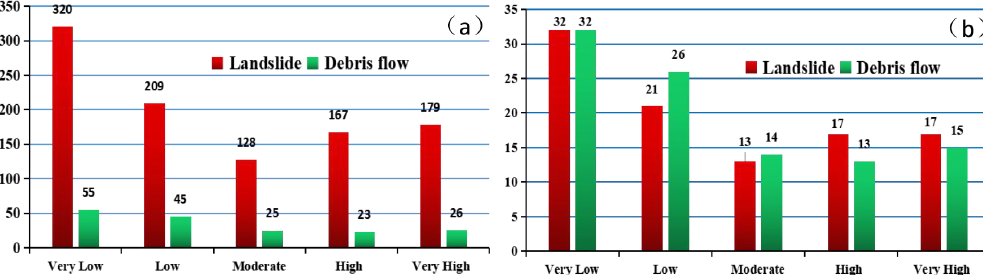
Figure 9. Numbers and percentage of units in different susceptibility classes for landslide and debris flow: (a) number of units in different susceptibility classes for landslide and debris flow and (b) percentages of different susceptibility classes for landslide and debris